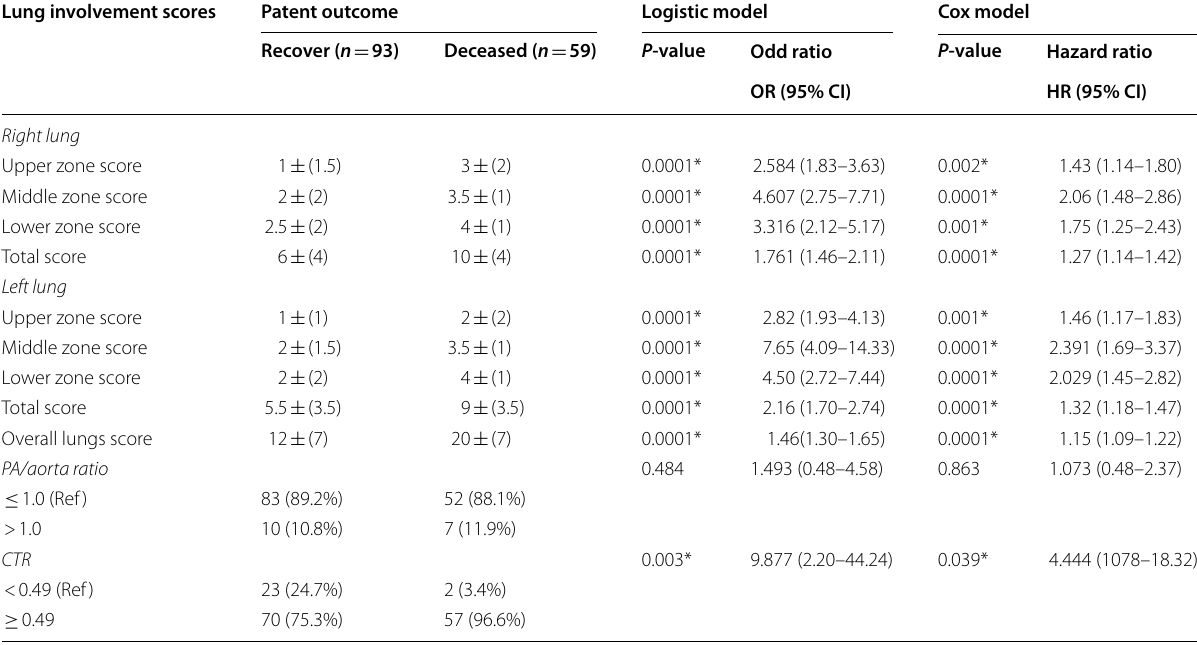
Table 4 Characteristics of mortality prediction and hazard ratio derived from the lung involvement scores and cardiovascular CT‑Parameters